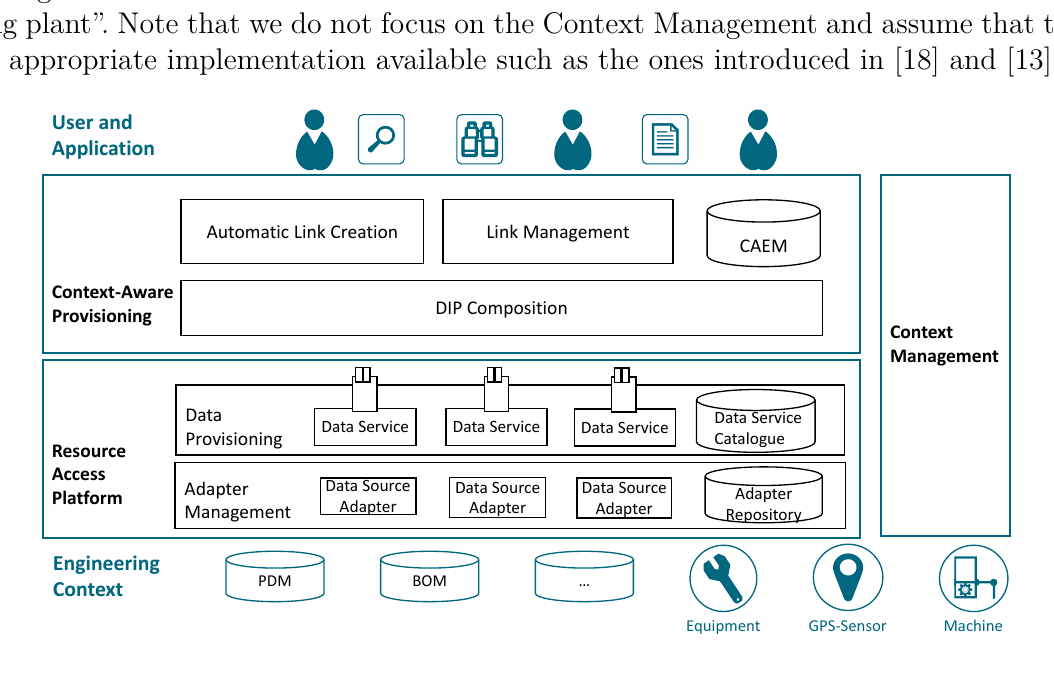
Figure 6. System Architecture to provision